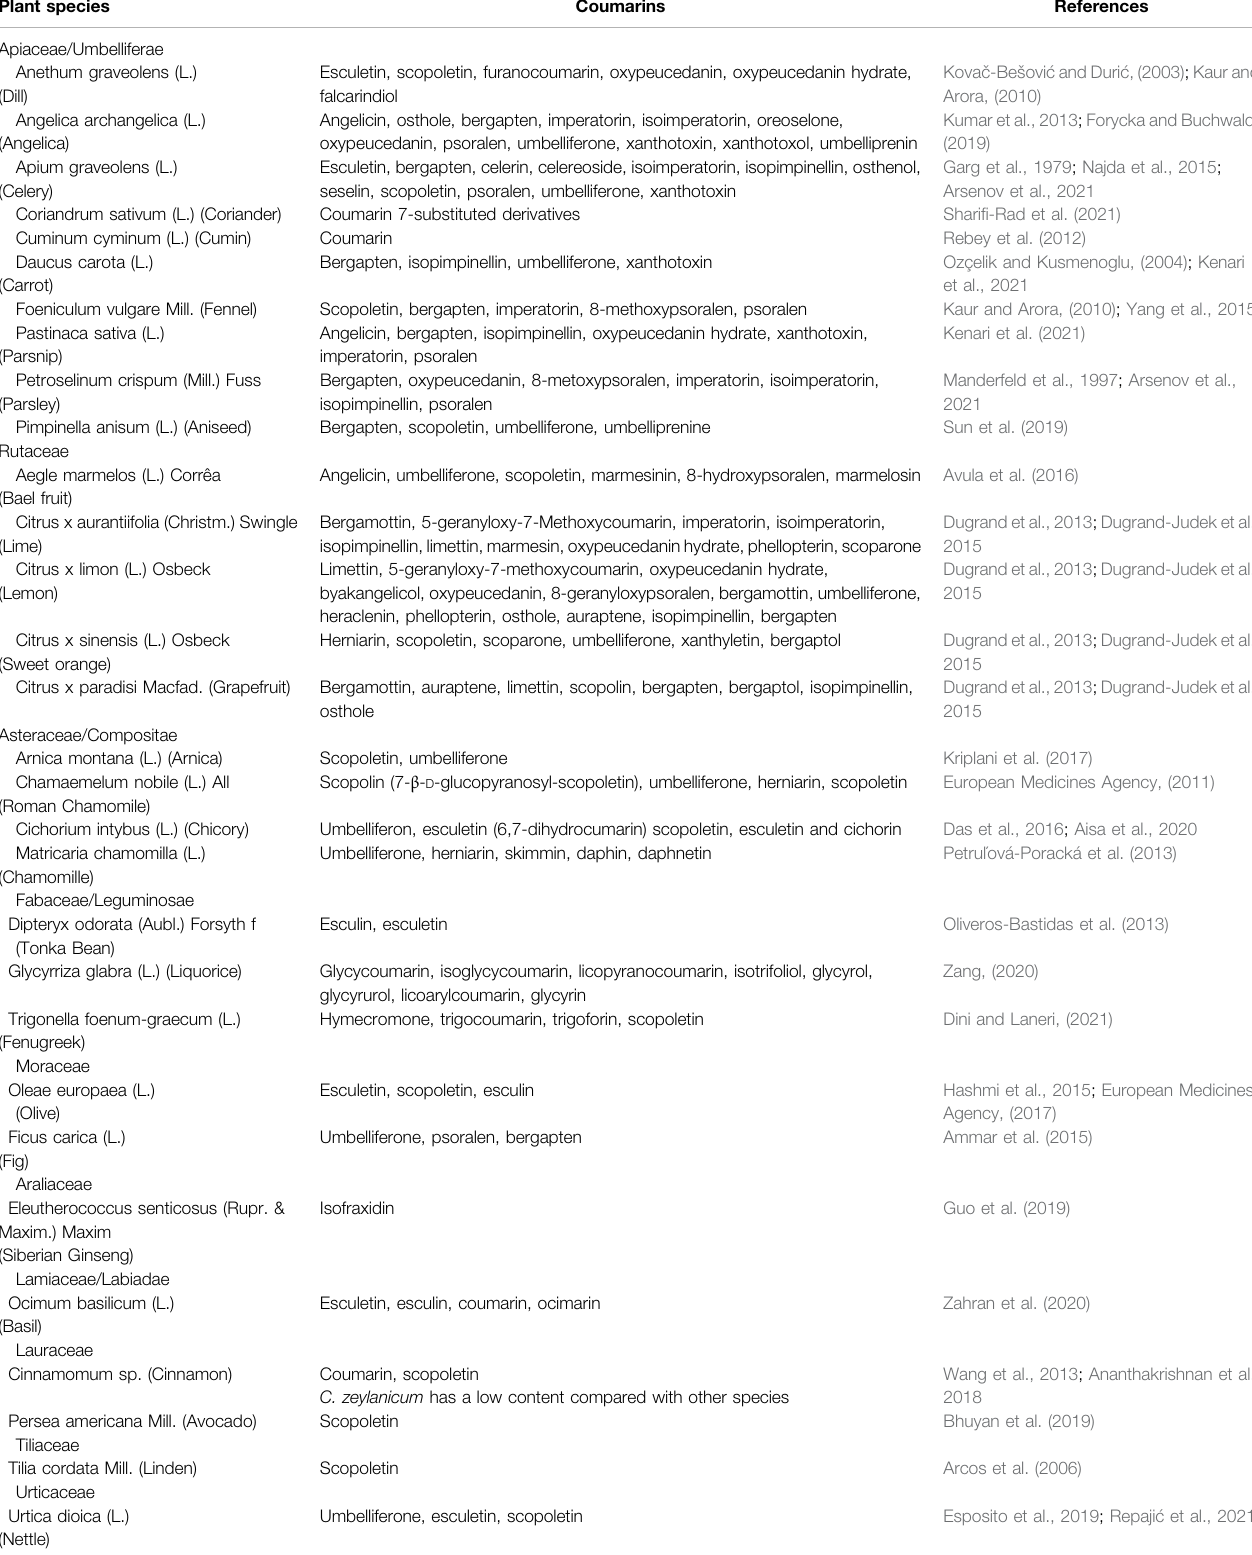
TABLE 1 | Main coumarins and their vegetal